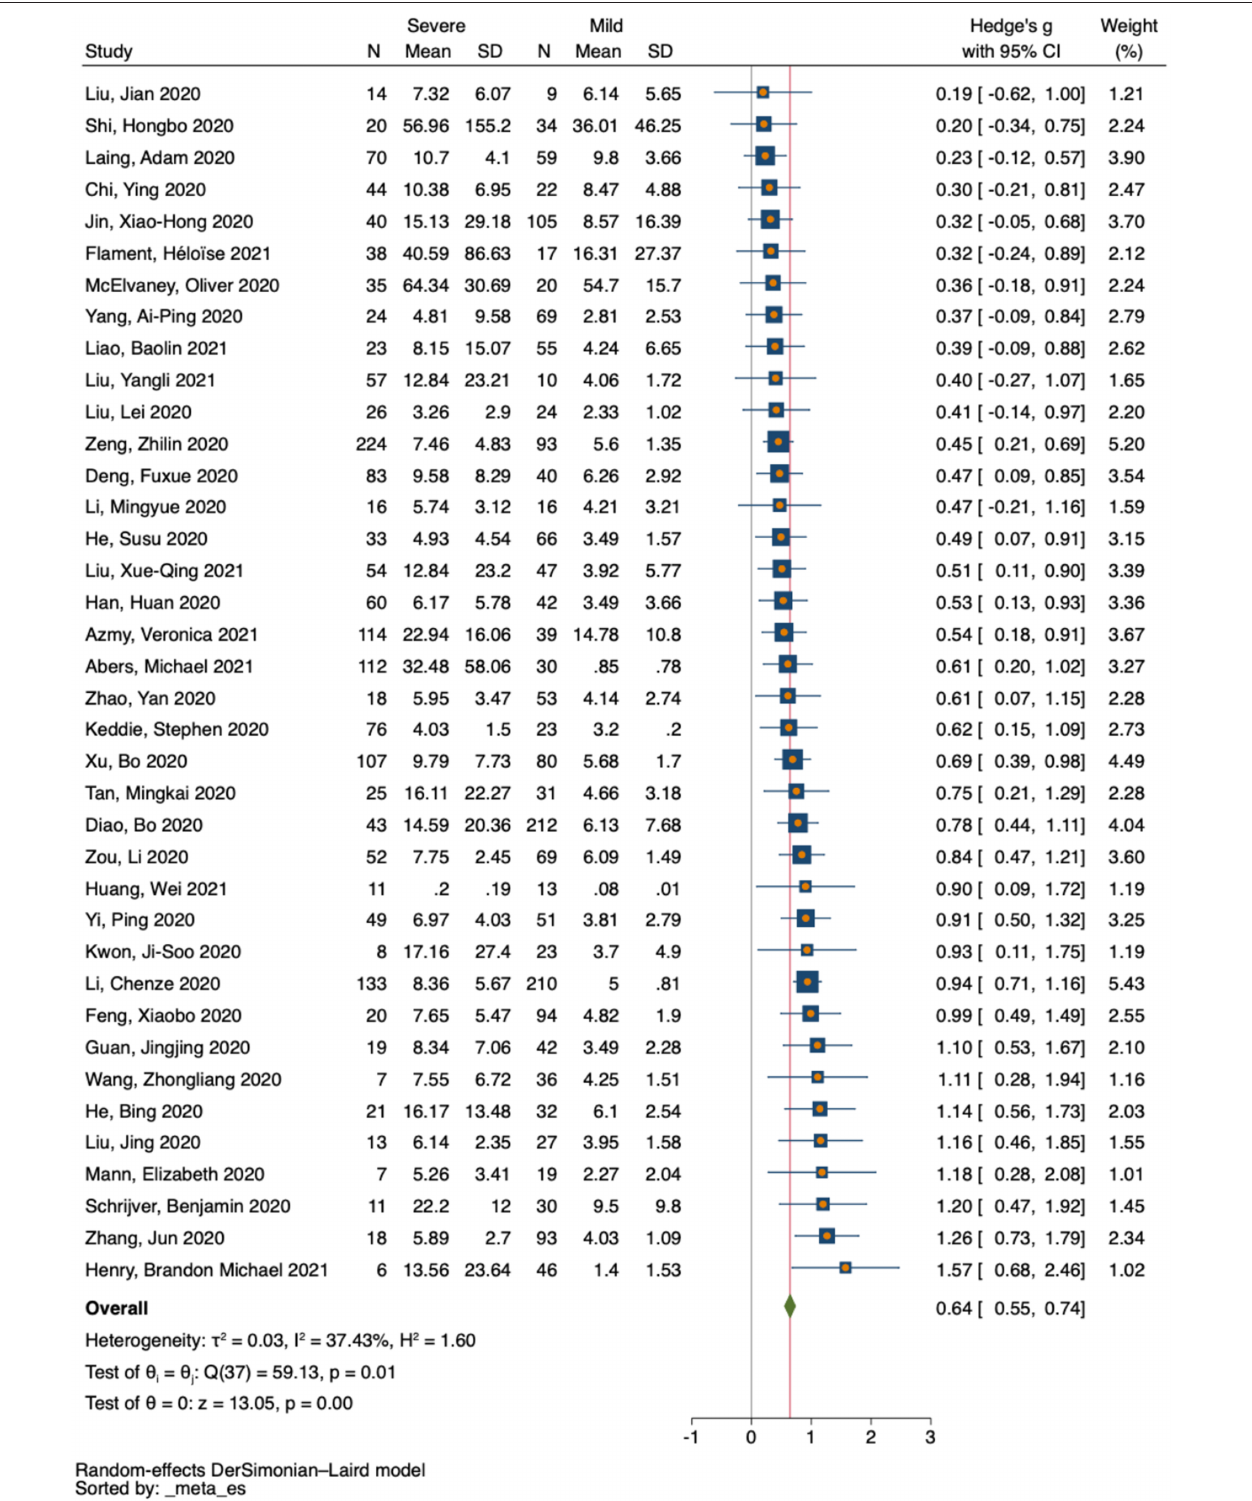
Frontiers in Medicine |